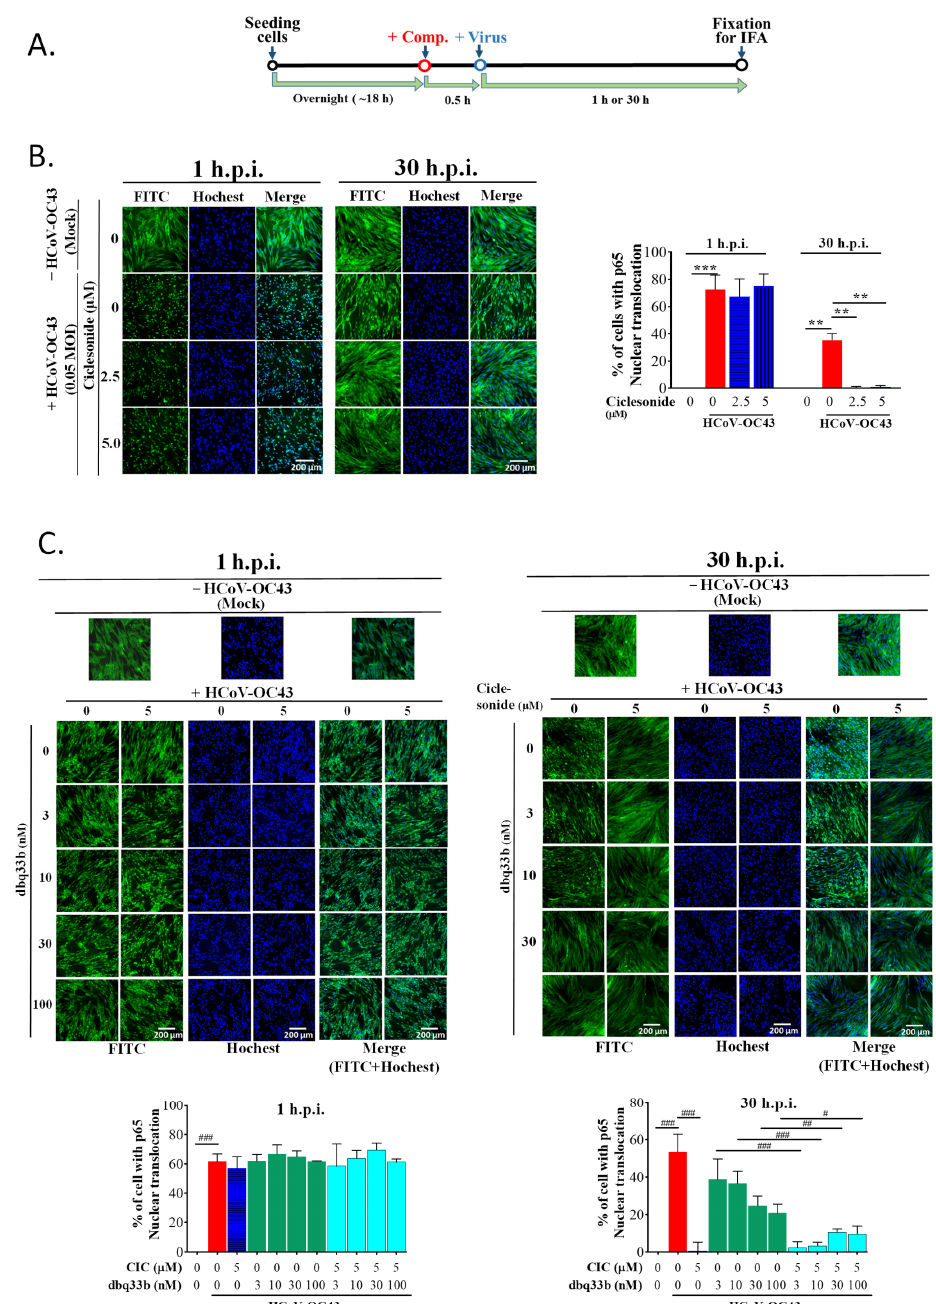
Figure 3. The effects of combined treatment with ciclesonide and tylophorine-based dbq33b on the p65 nuclear translocation/NF- κ B activation induced by HCoV-OC43 infection in MRC-5 cells. ( A ) Scheme for the sequence in which the HCoV-OC43 infection and compound treatments were performed. ( B ) The effect of ciclesonide on p65 translocation into nuclei induced by HCoV-OC43 infection in MRC-5 cells. ( C ) The effects of tylophorine-based dbq33b alone or in combination with ciclesonide on p65 translocation into nuclei induced by HCoV-OC43 infection in MRC-5 cells. After fixation, cells were treated with CF ® 488A goat anti-rabbit IgG for anti-p65 (green) and their nuclei visualized by staining with Hoechst (blue). Images were acquired using an ImageXpress Micro XLS Wide field High-Content Screening System under “autofocus” function and the best z-offset. Results shown are representative of three independent experiments and AVE ± S.D. from three independent experiments. (** p < 0.01, *** p < 0.001 for student’s t -test; # p < 0.05, ## p < 0.01, ### p < 0.001 for two-way ANOVA test). (Large images for ( B , C ) were provided in “Supplemental